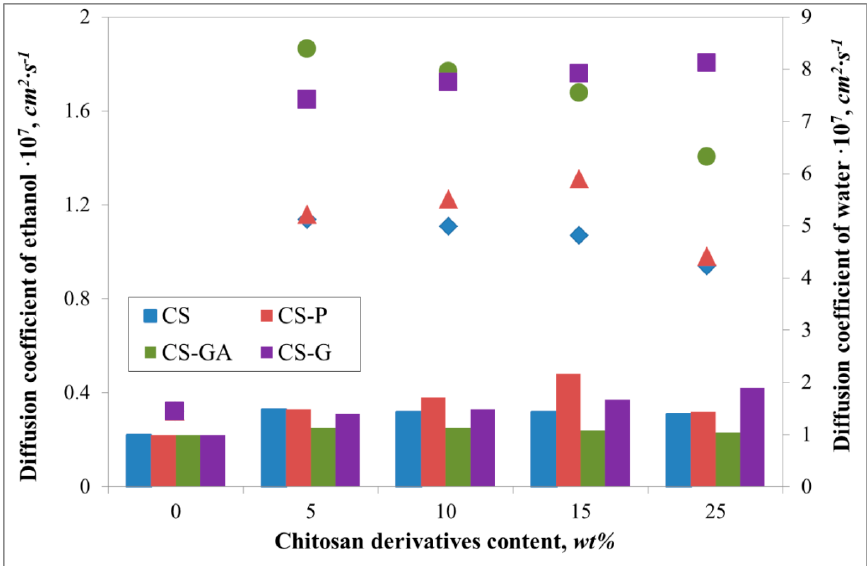
Figure 4. The variation of evaluated diffusion coefficients of water (filled symbols) and ethanol (bar chart) for Alg membranes with increasing content of neat chitosan (CS) and modified CS microparticles; phosphorylated chitosan (CS-P), glutaraldehyde crosslinked chitosan (CS-GA), and glycidol-modified chitosan (CS-G).